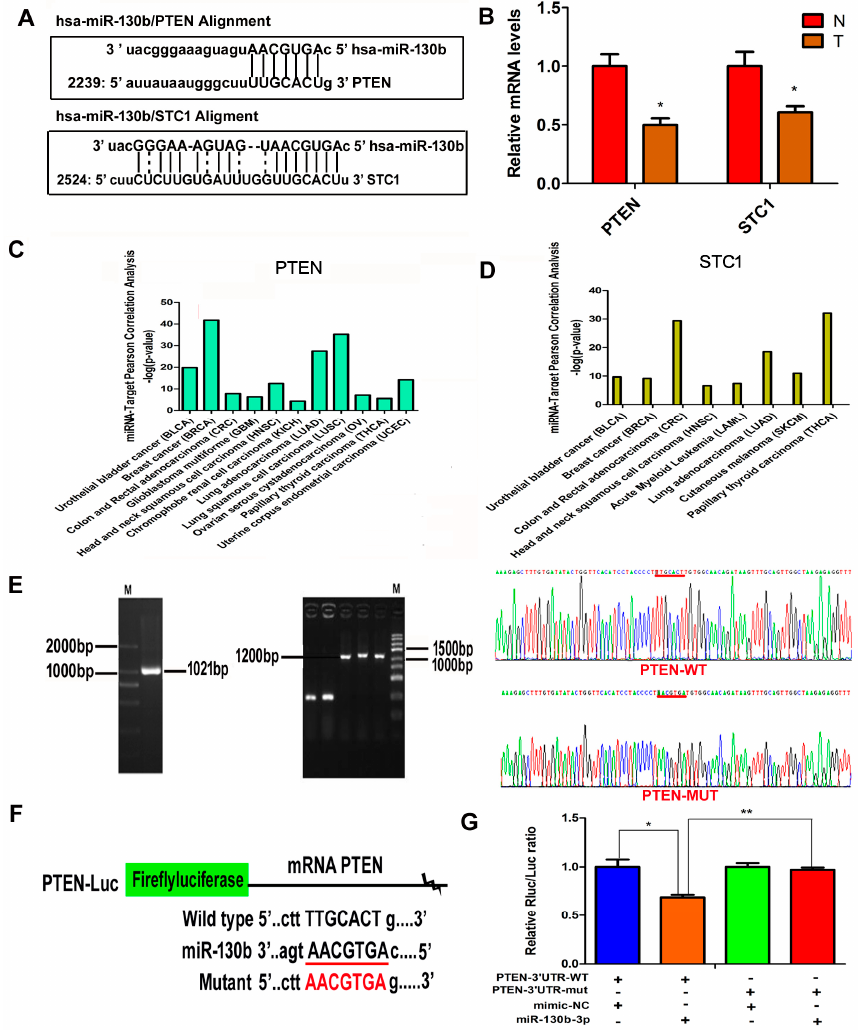
Figure 5. Targets of miR-130b-3p are identified. ( A ) The putative binding sites between miR-130b-3p and PTEN 3 (cid:48) -UTR or stanniocalcin 1 (STC1) 3 (cid:48) -UTR; ( B ) The relative expression levels of PTEN and STC1 in thirty pairs of tumor tissues (T) and normal tissues (N). Data are shown as mean ± SEM. * p < 0.05, n = 30; ( C , D ) miR-130b/target PTEN or STC1-cancers Pearson correlation analysis according to starbase function prediction; and ( E – G ) Luciferase activity in 293T cells co-transfected miR-130b-3p with luciferase reporters containing PTEN 3 (cid:48) -UTR or mutant. Data are presented as the relative ratio of Renilla luciferase activity to fireflyluciferase activity. n = 3, mean ± SD. * p < 0.05, ** p < 0.01. The red lines in the Figure 5E,F are the binding site and mutation site of PTEN binding to miR-130b-3p. The red character in the Figure 5F is the mutation